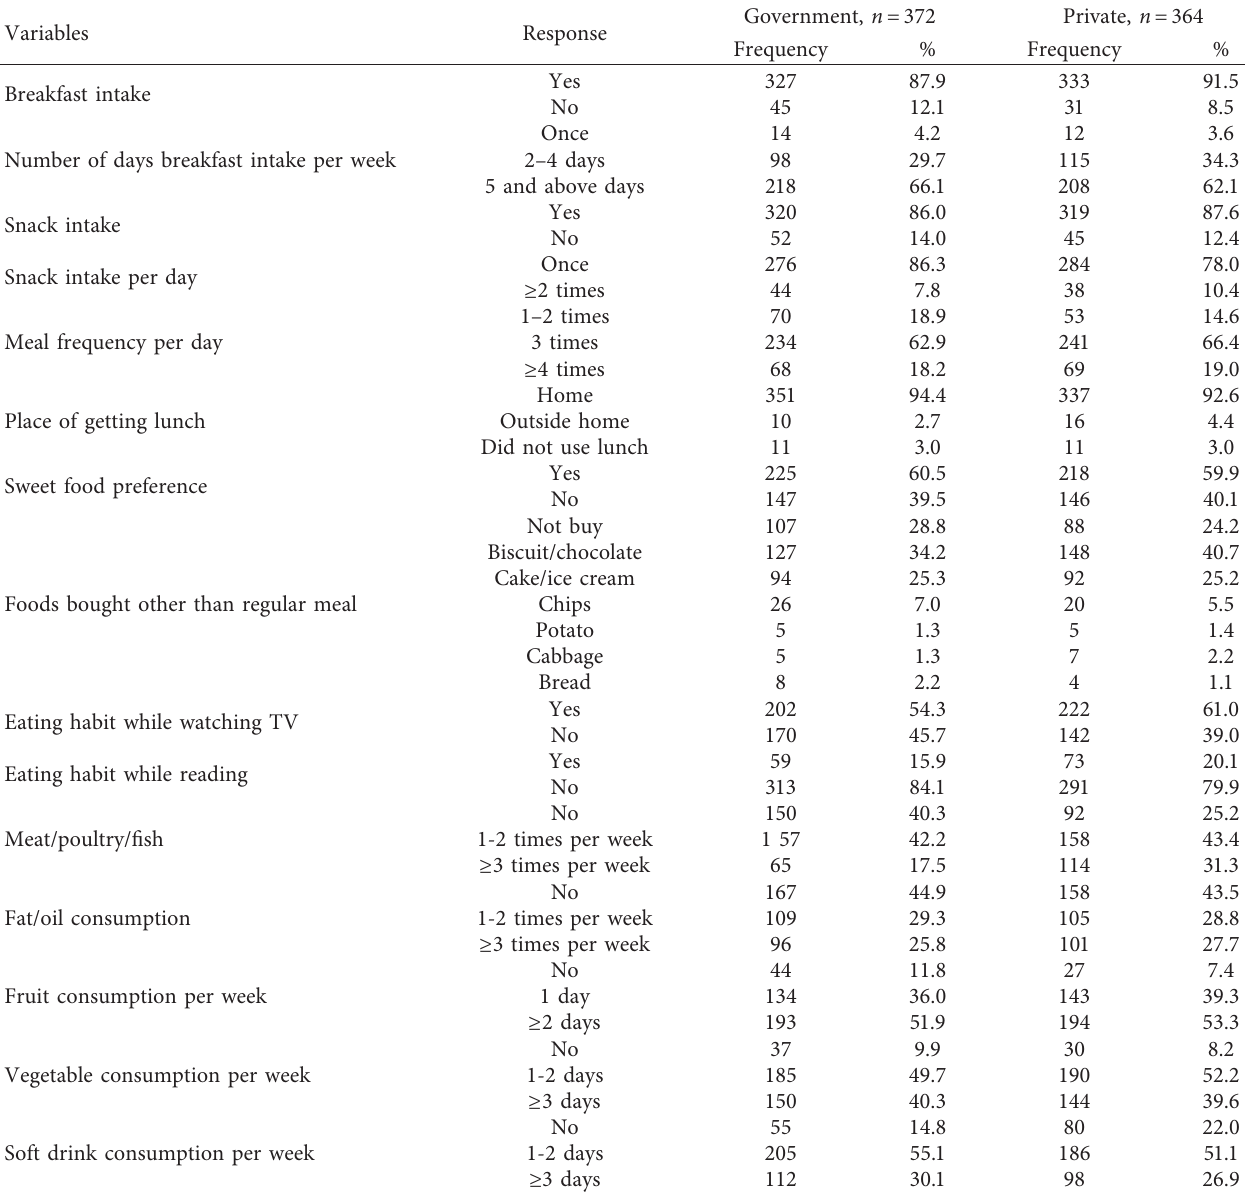
Table 3: Dietary habit and food preference related characteristics among primary school students in Gondar town, 2019 ( n � 736).